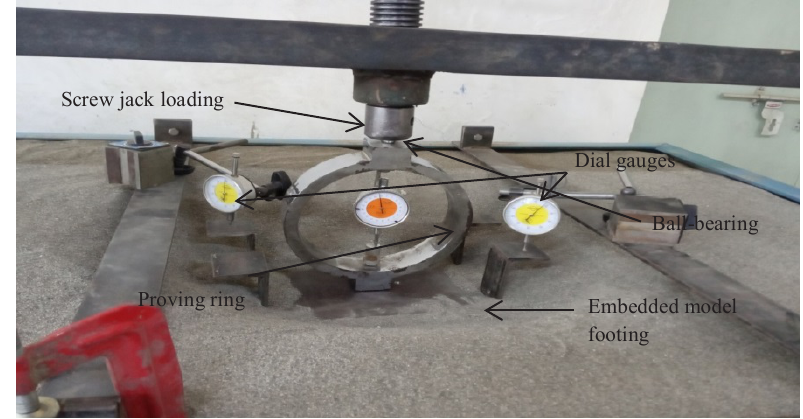
Figure 2(a): Test arrangements of embedded model Fig. 2(a) Test arrangements of embedded model footing